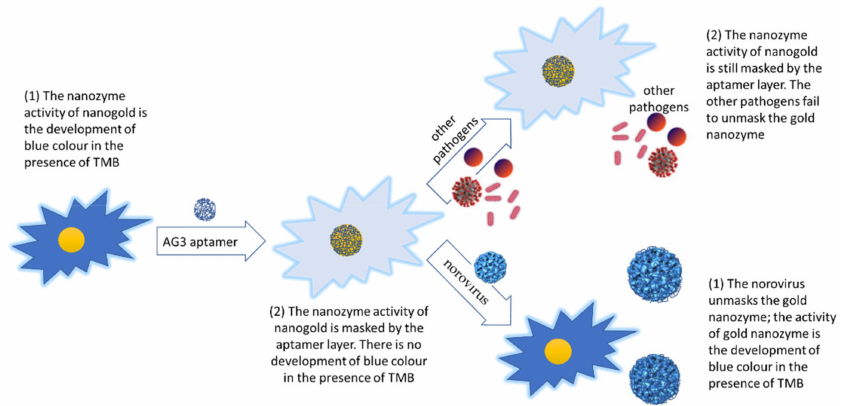
Figure 4. Graphical illustration of the novel colorimetric nanozyme strategy for detection and identification of the foodborne human